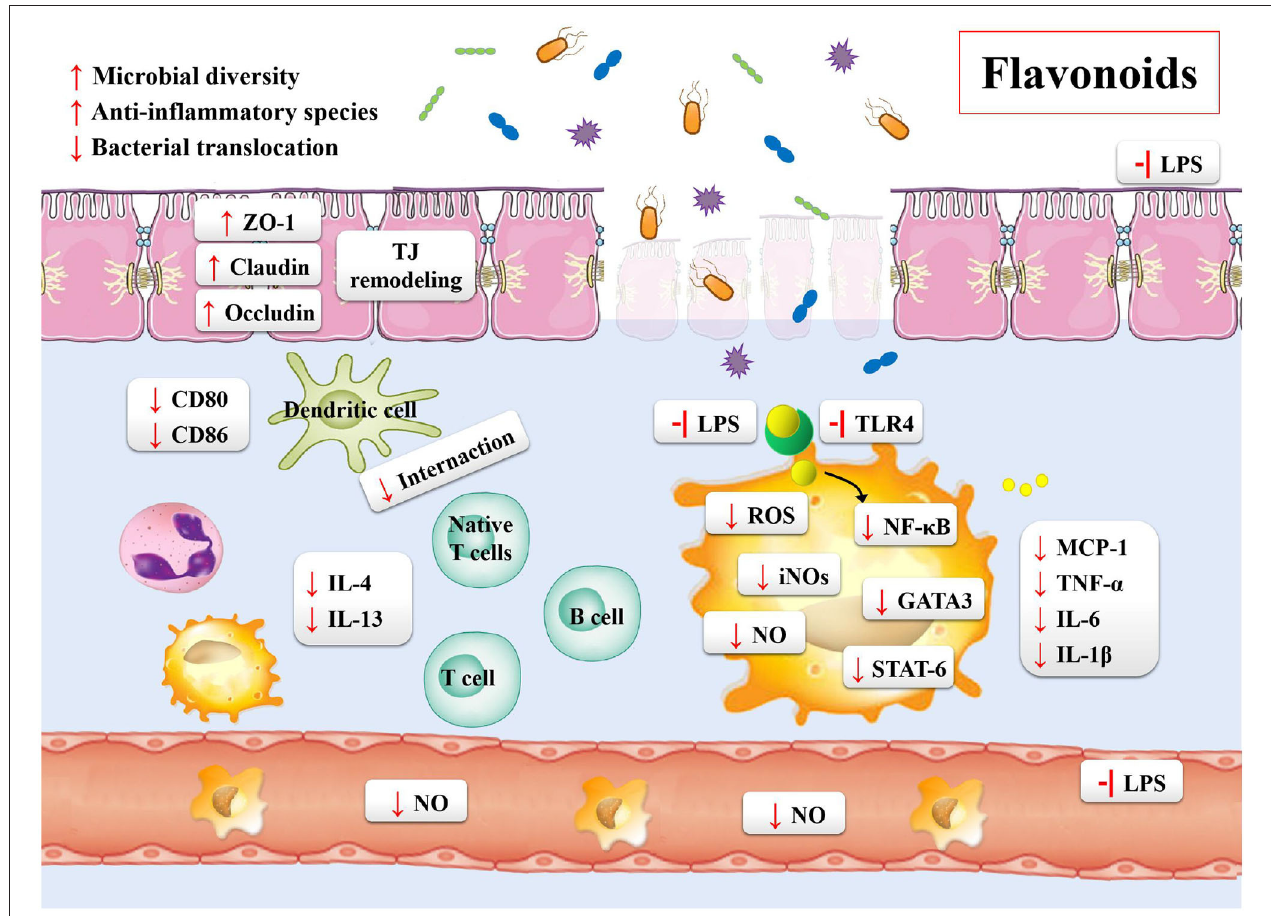
FIGURE 4 | The potential mechanisms of flavonoids on gut microbiota and